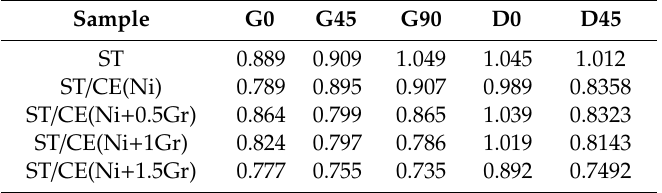
Figure 11. Friction coe ffi cient under stable friction for di ff erent ST / CE surface. ( a – c ) The stable friction coe ffi cients of GST at 0 ◦ , 45 ◦ and 90 ◦ , respectively. ( d ) and ( e ) the stable friction coe ffi cients of DST at 0 ◦ and 45 ◦ , respectively. Table 5. Friction coe ffi cient of stable friction for all the textured composite electroplating